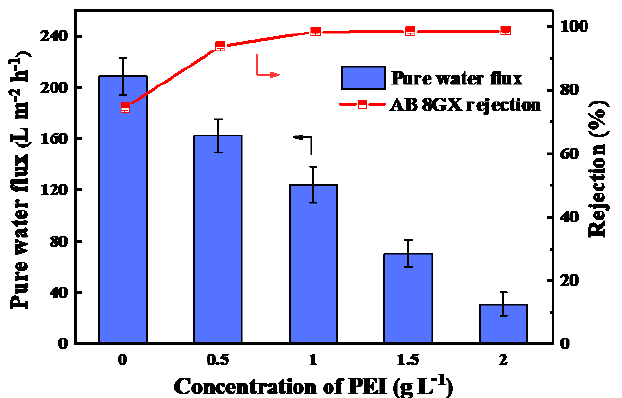
Figure 5. The pure water flux and AB 8GX rejection of PES/Fe-TA-PEI membranes with different PEI concentration.